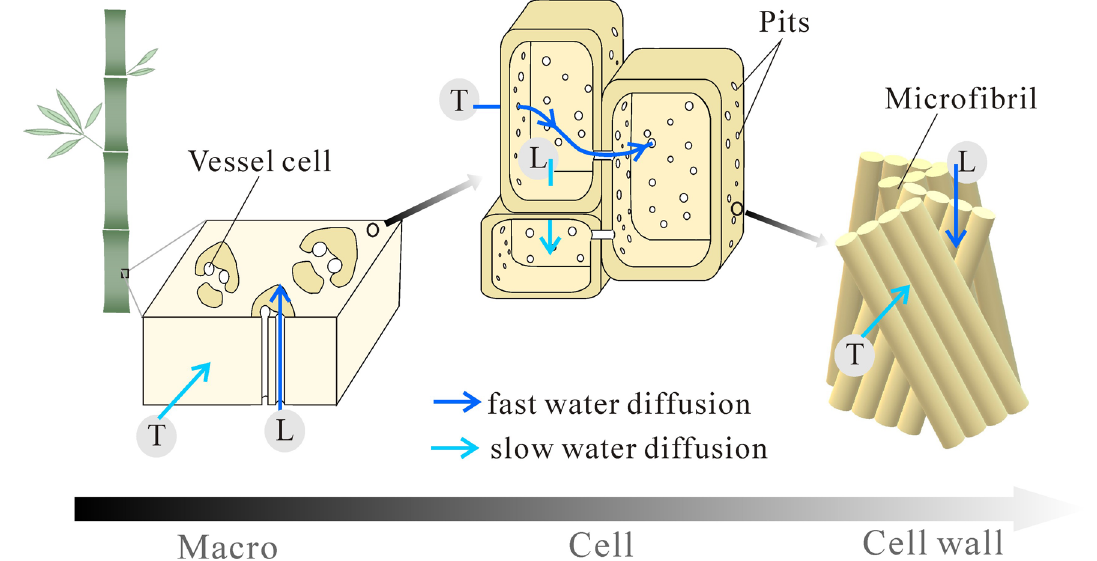
Figure 6. Schematic illustration of multi-scale water vapor diffusion paths in